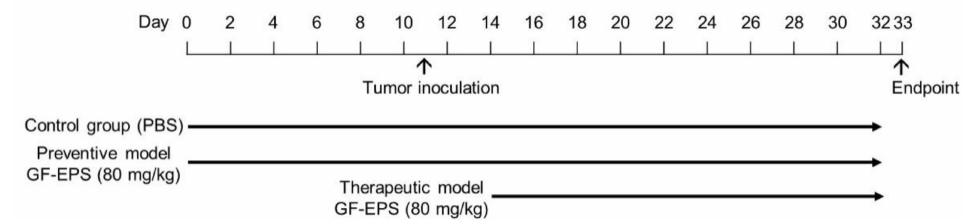
Figure 2. Flow chart of the animal experiment, including preventive ( n = 6) and therapeutic models ( n = 6). GF-EPS was orally administered to mice every other day for 32 d and control group mice ( n = 6) received PBS every other